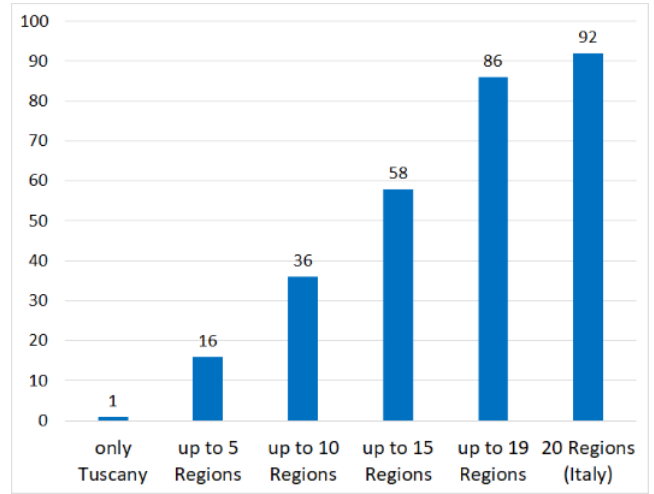
Figure 5. Distribution at Italian regional scale of the 92 species of the AlimurgITA database mentioned by Giovanni Targioni Tozzetti [6] and still used in Tuscany.